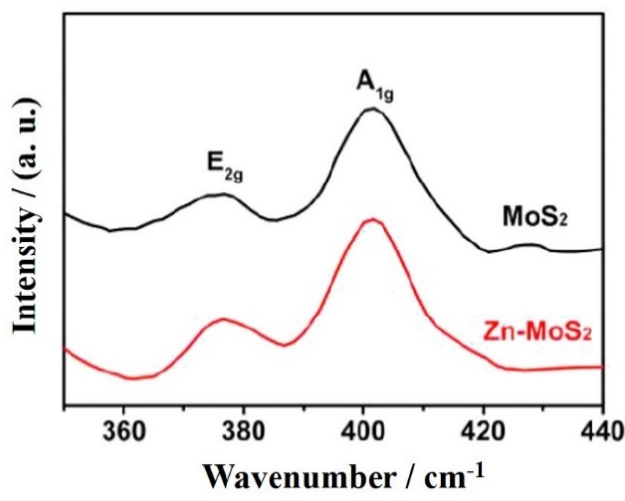
Figure 8. Raman characteristics of pure MoS 2 (black line) and Zn-MoS 2 (red line) [27].